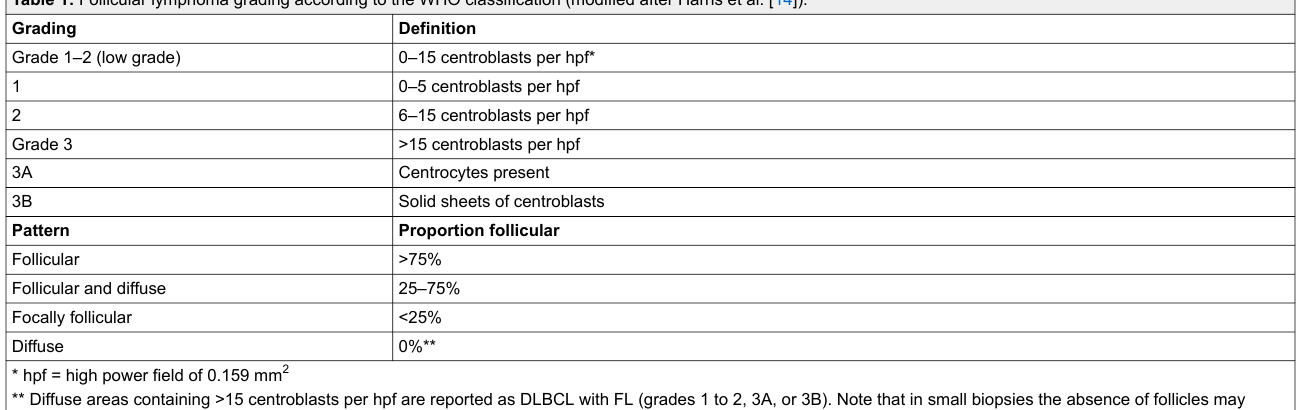
Table 1: Follicular lymphoma grading according to the WHO classification (modified after Harris et al. [14]). Grading